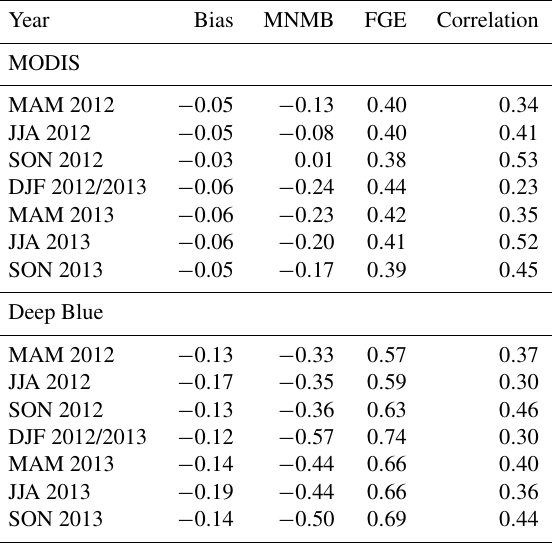
Table 3. Mean statistics of the comparison between the MODIS AOD and the MOCAGE simulation for the different seasons in- cluded in the years 2012 and 2013. See Appendix A for information about statistical indicators.